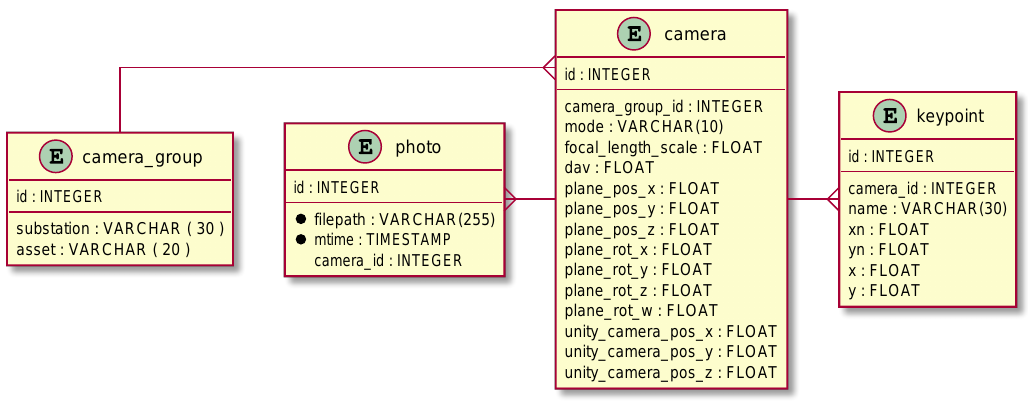
Figure 6. Backend simplified database